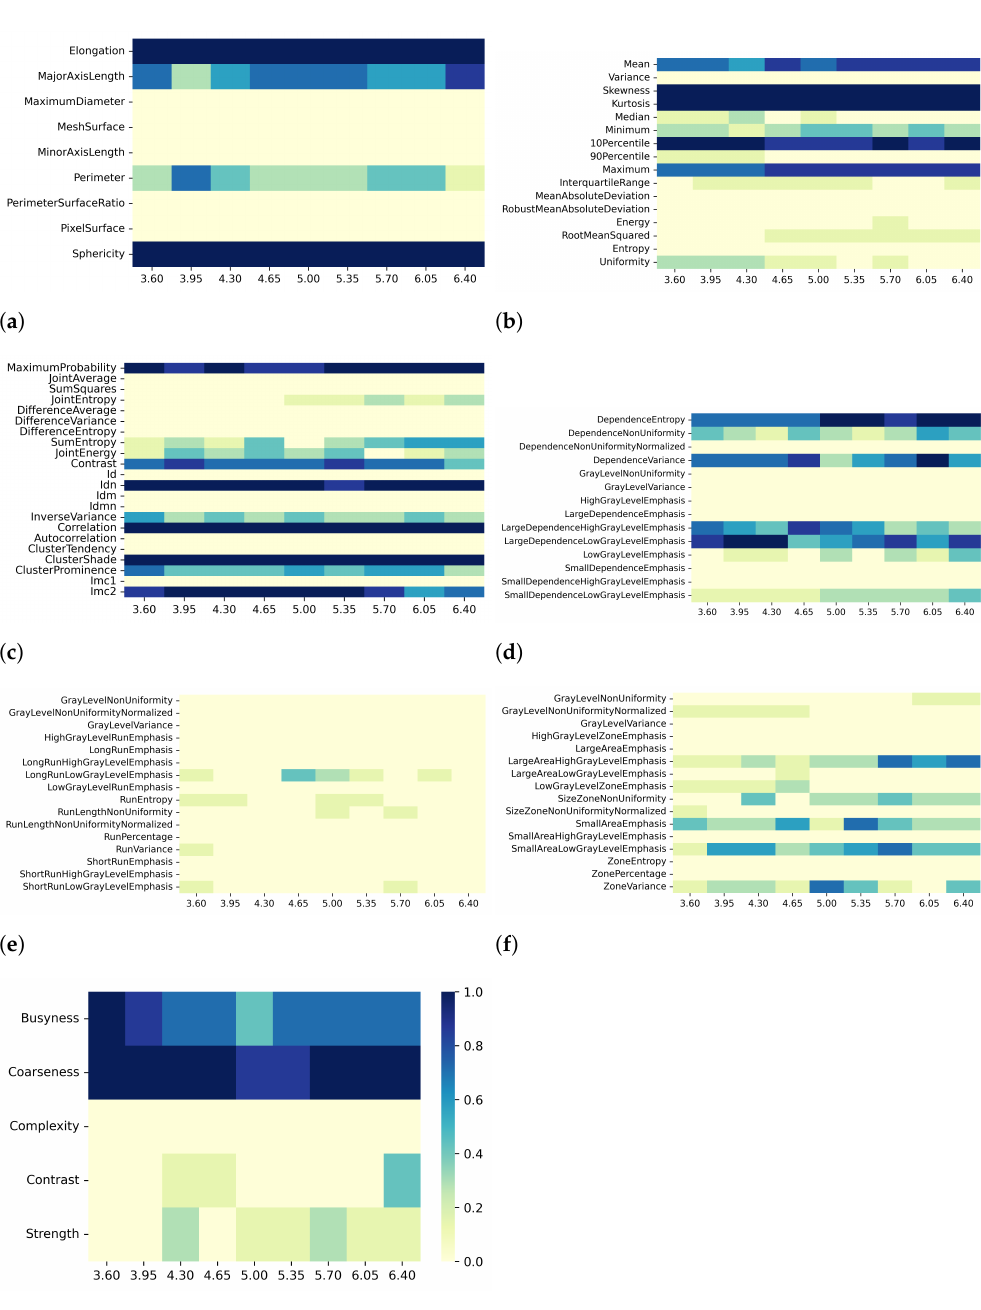
Figure 2. Heatmaps of remaining features from T1 maps after PCC-based dimensionality reduction for effect A (varying resampling voxel size, with fixed discretization bin width (ms)). The radiomic features are separated in different classes: ( a ) 2D shape, ( b ) first order, ( c ) GLCM, ( d ) GLDM, ( e ) GLRLM, ( f ) GLSZM, ( g )